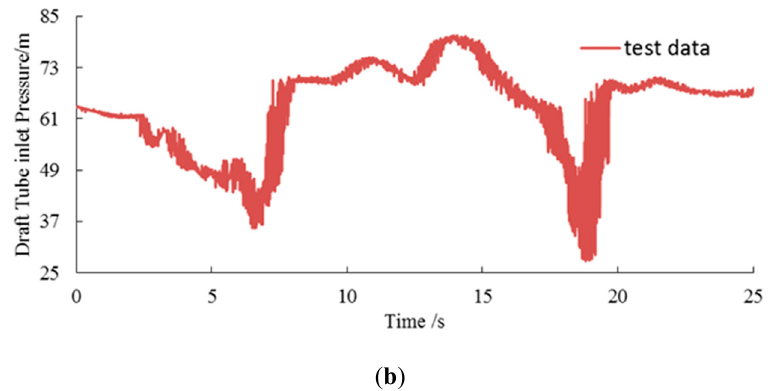
Figure 7. Pre-filtering pressure process line: ( a ) Spiral case pressure; ( b ) Draft tube inlet pressure.